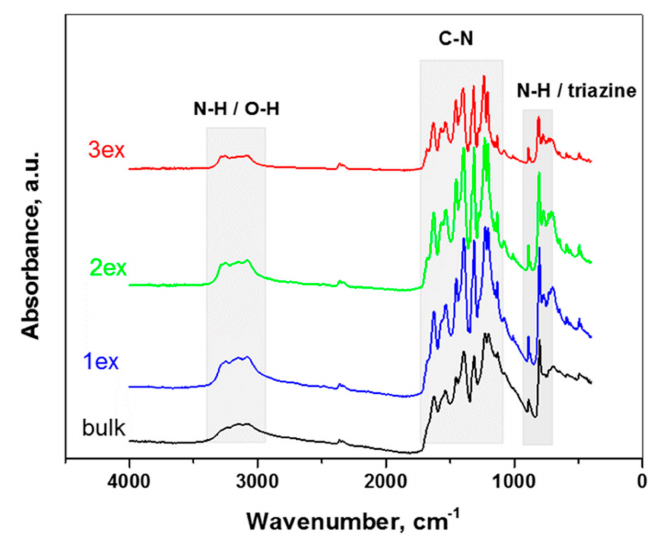
Figure 5. FT-IR spectra of the bulk and exfoliated (1ex, 2ex and 3ex) g-C 3 N 4 .